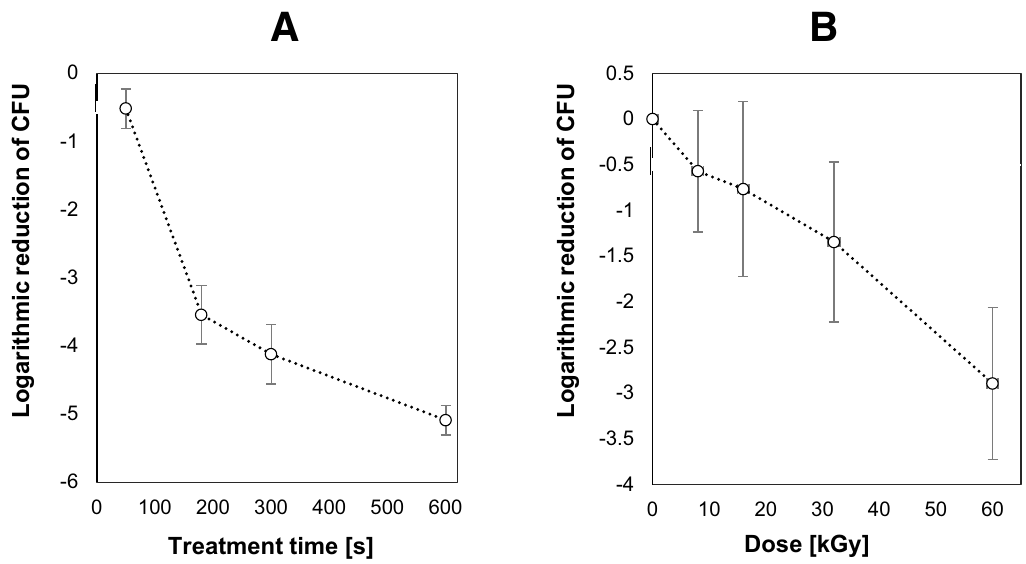
Figure 1. Inactivation kinetics for artificially inoculated E. coli on lentil seeds as a function of CAP treatment time ( A ) and inactivation kinetics for artificially inoculated E. coli on lentil seeds as a function of LEEB radiation dose ( B ). Error bars express standard deviation of the mean of triplicates for each data point.